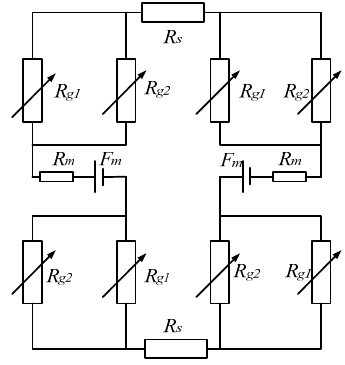
Figure 6. The equivalent magnetic circuit of a phase.